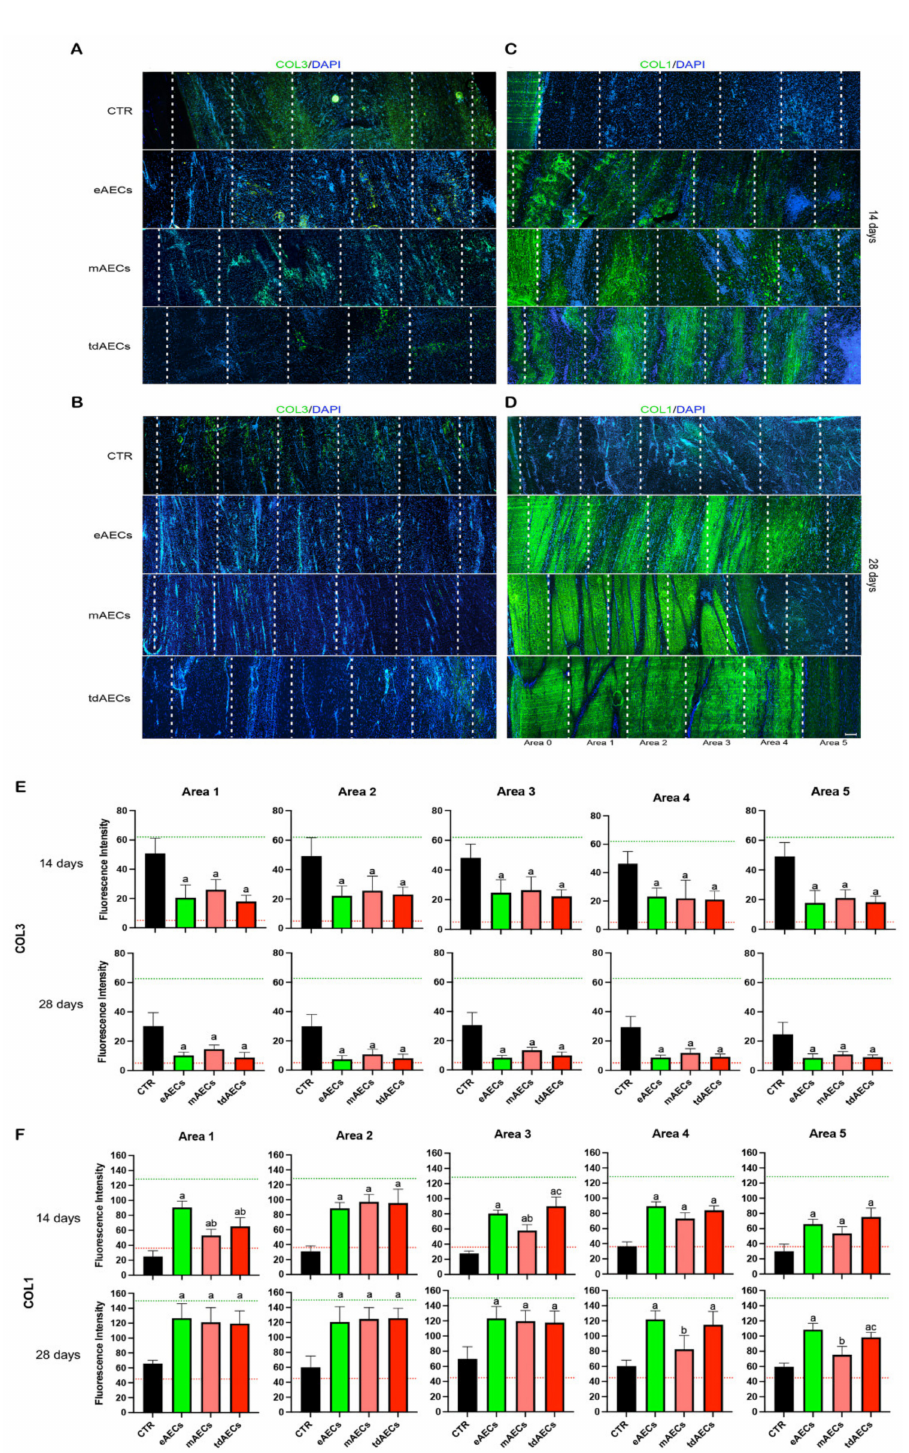
Figure 5. ECM composition after transplantation of eAECs, mAECs, and tdAECs in injured tendons. In each panel the healthy portion (area 0 positioned on the left in all images) and the injured area of CTR and treated explants (from area 1 to area 5) are shown with white dashed lines. COL3 (green fluorescence) representative images at ( A ) 14 days and ( B ) 28 days which was undetectable in healthy tissues (area 0) an barely expressed in eAEC-, mAEC- and tdAEC-treated tendons especially at 28 days, whereas it persisted in CTR tendons at all time points. Representative images of COL1 fibers (green fluorescence) at ( C ) 14 days and ( D ) 28 days which were detected in the healthy portion of the explants (area 0) and within the injury site of eAEC-, mAEC-, and tdAEC-transplanted tendons. Nuclei were counterstained with DAPI. Scale bar = 100 µ m. Representative histograms of green fluorescence intensities of ( E ) COL3 and ( F ) COL1 at